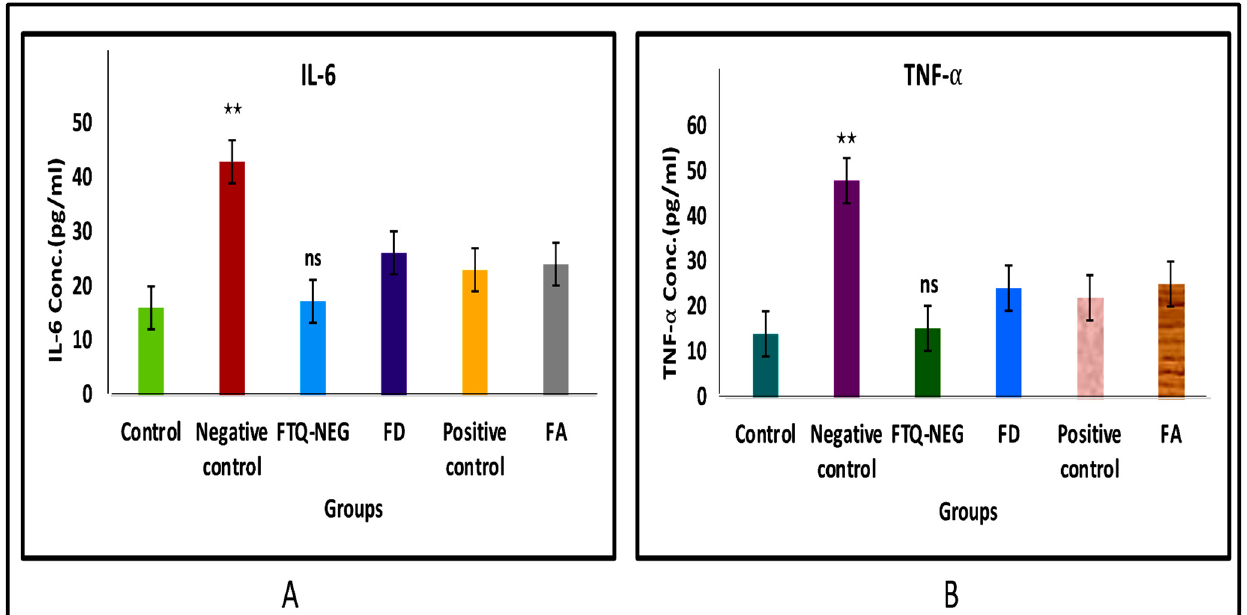
Figure 11. Levels of IL-6 ( A ) and TNF- α ( B ) that were assessed in skin homogenate of different animal groups: Control, Negative control, FTQ-NEG, FD, Positive control, and FA (** indicate p < 0.01) and ns is